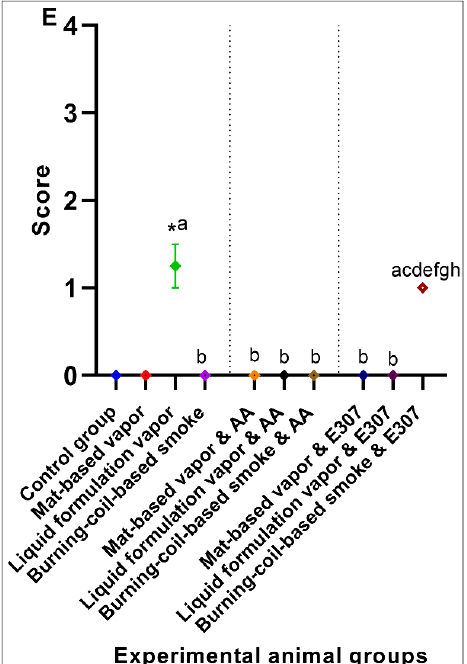
Figure 7. Effects of ascorbic acid (AA) and α -tocopherol (E307) on pyrethroid-induced toxicity in the kidneys of animals showing congestion ( A ), degeneration ( B ), glomerular necrosis ( C ), hyperemia ( D ), and occlusion ( E ). Values are expressed as mean ± S.E. The Kruskal–Wallis non-parametric test